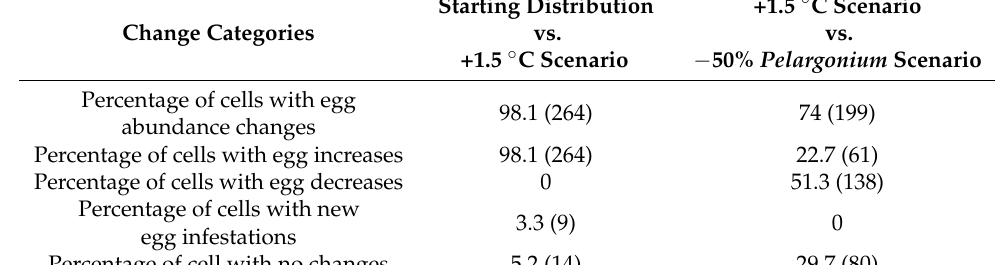
Table 4. Percentages of cells showing changes in egg abundance under different scenarios.